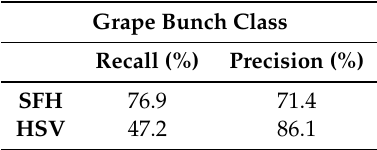
Table 3. Grape bunch class recall and precision for SFH and HSV